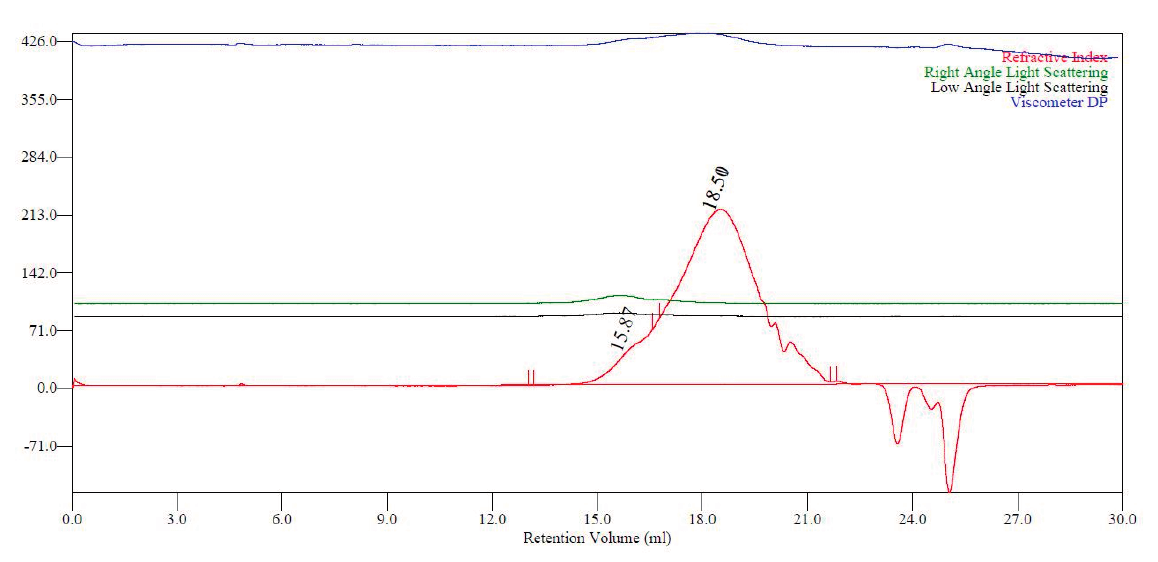
Figure 3. Triple detection GPC chromatogram for PBI